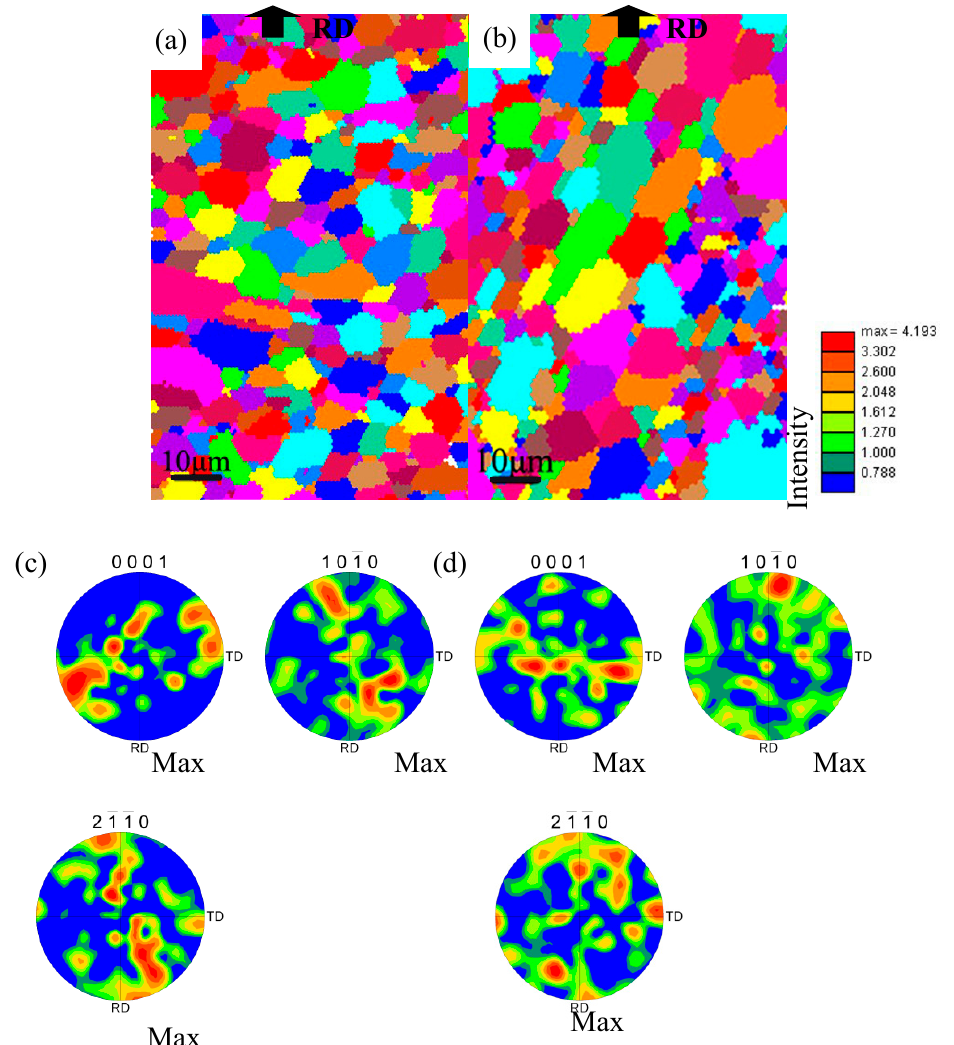
Figure 5. Variations of the texture and corresponding (0001),{1010}, and{2110} pole figures in the forged alloy and extruded alloy. ( a ) and ( c ) forged alloy, ( b ) and ( d ) extruded alloy. RD and ND mean the rolling direction and the normal direction of the sample, respectively, and TD means the transverse direction. The analyzed planes were taken from the plane of RD and TD, which was perpendicular to